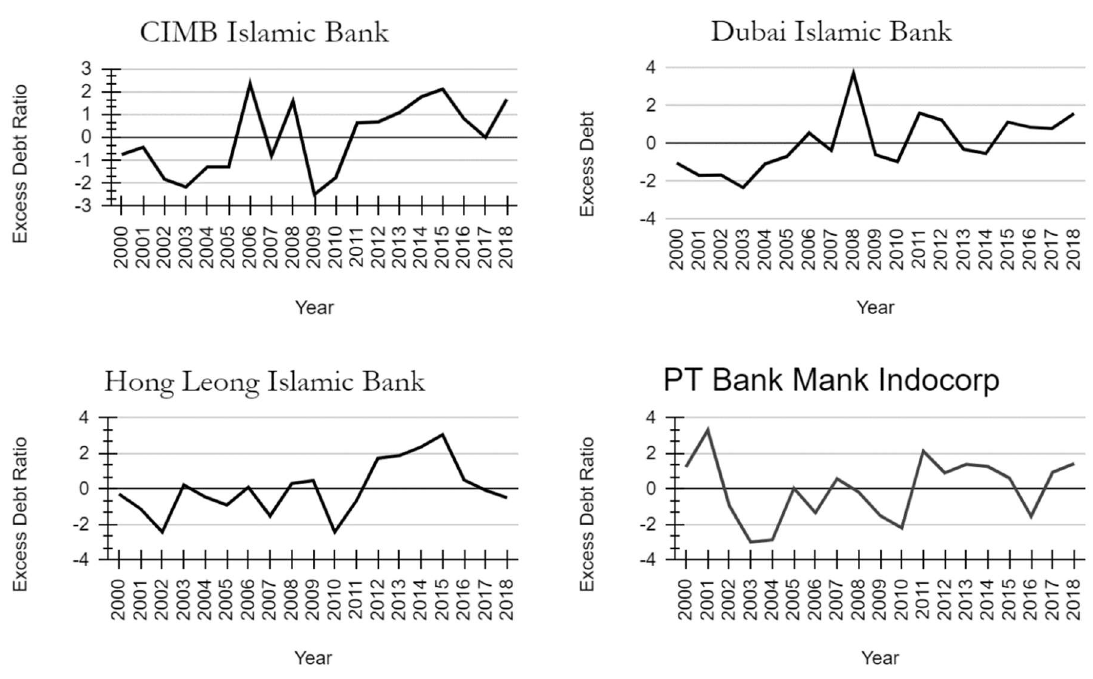
Figure 4. Excess debt ratio for Islamic banks. Source: author’s calculations.